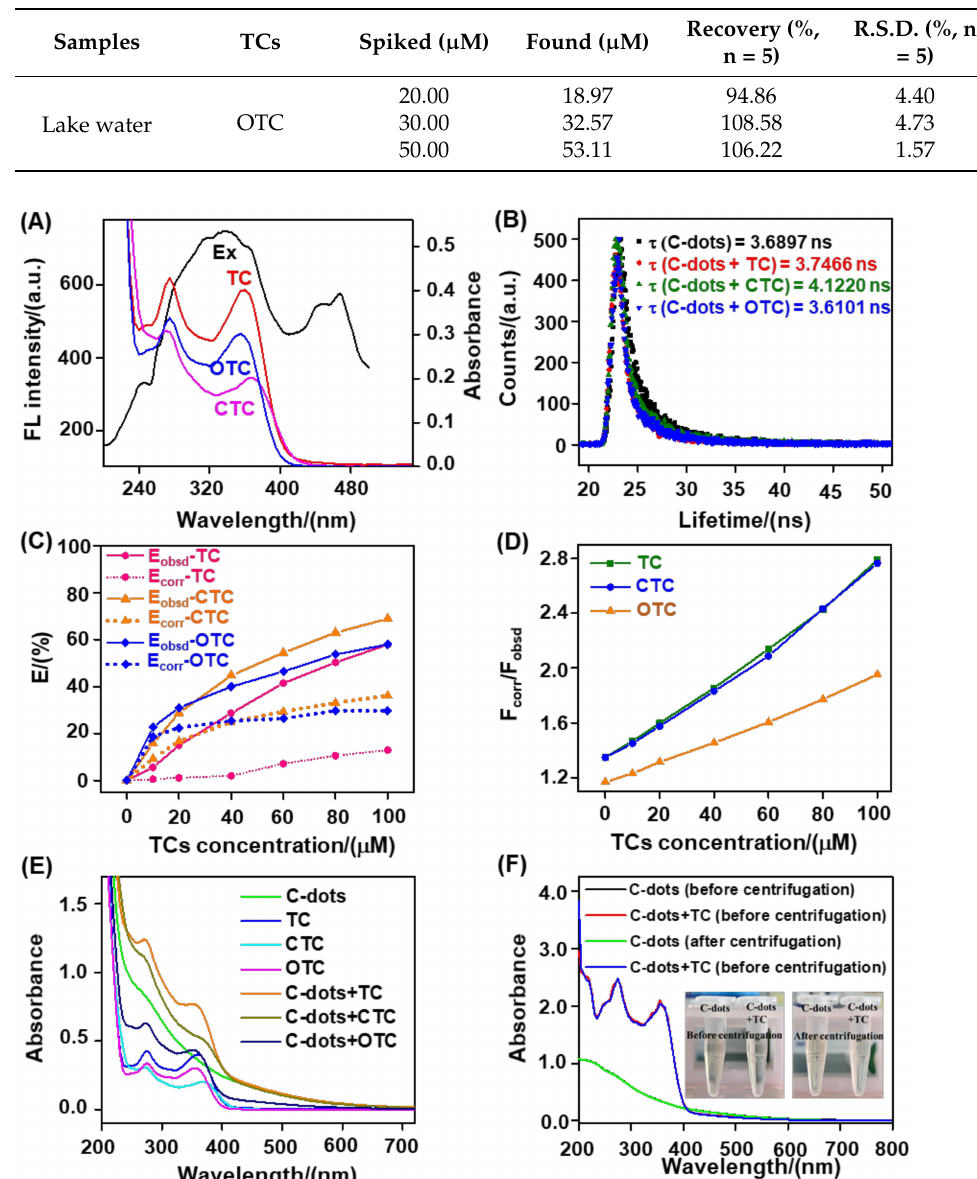
Figure 6. Profiling the fluorescent response mechanism of the biomass − based C − dots toward TCs in BR buffer (pH = 5.0 for TC and pH = 4.0 for CTC and OTC). ( A ) Fluorescence excitation (Ex) spectrum of C − dots and the absorption spectra of TC, OTC, and CTC. ( B ) Fluorescence lifetime decay curves of the biomass-based C − dots in the absence and presence of TC, OTC, and CTC. ( C ) Curves of F corr/ F obsd versus TC concentration. F corr and F obsd correspond to the corrected and observed fluorescence intensities of the C − dots − TC reaction system at 520 nm, respectively. ( D ) Observed and corrected fluorescence decrease efficiency (E) of the biomass-based C − dots caused by TC, CTC, and OTC. E = ( F 0 − F )/ F 0 , F 0 , and F are assigned to the fluorescence intensities of the biomass-based C − dots at 520 nm in the absence and presence of TCs. ( E ) Absorption spectra of the biomass- based C − dots, TC, CTC, OTC, C − dots + TC, C − dots + CTC, and C − dots + OTC. ( F ) Absorption spectra of the biomass − based C − dots and C − dots + TC before and after centrifugation. Inset shows corresponding photographs as indicated by the absorption spectra. The concentrations of the biomass − based C − dots and TCs were 25.0 (for TC and CTC) or 10.0 (for OTC) µ g/mL and 50.0 µ M,